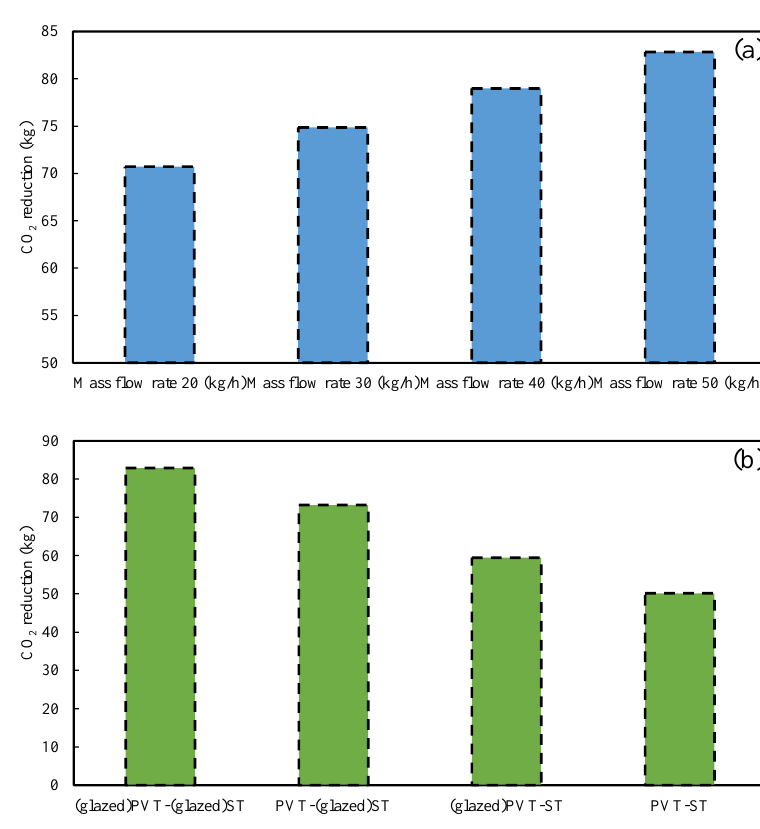
Fig. 15. CO2 reduction for (a) (glazed)PVT/(glazed)ST system at different mass flow rates and (b) four different PVT/ST systems with and without glass cover on a typical day in August.